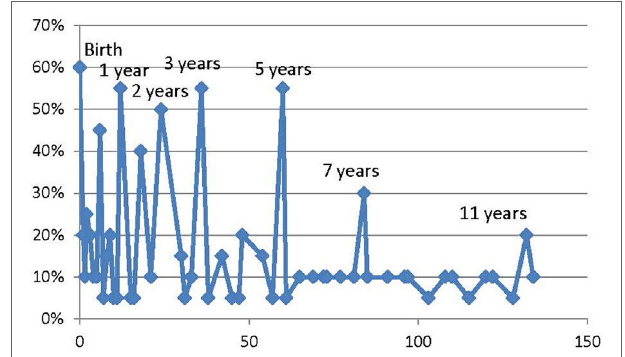
FiGURe 2 | Distribution of Scheduled Study Visits among 20 longitudinal birth cohorts. Consensus assessments points among multiple international cohort studies result in some consistent patterns.